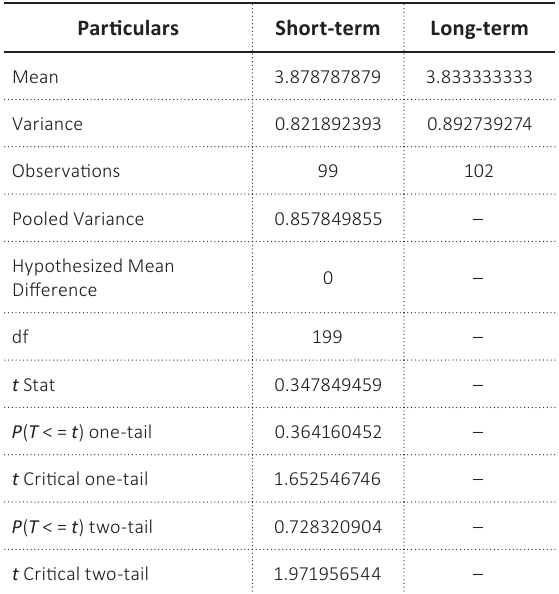
Table 10. t -test: Two-sample assuming equal variances